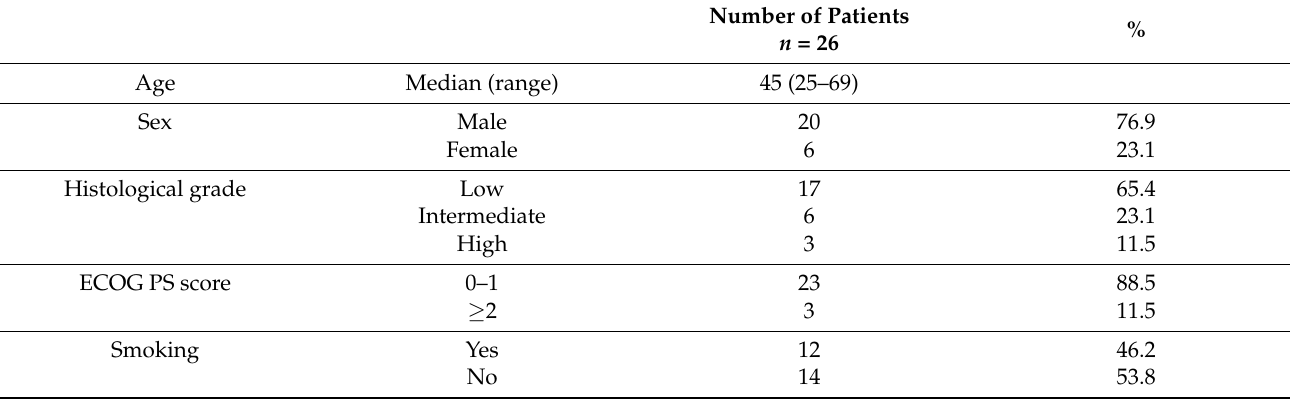
Table 1. Patient